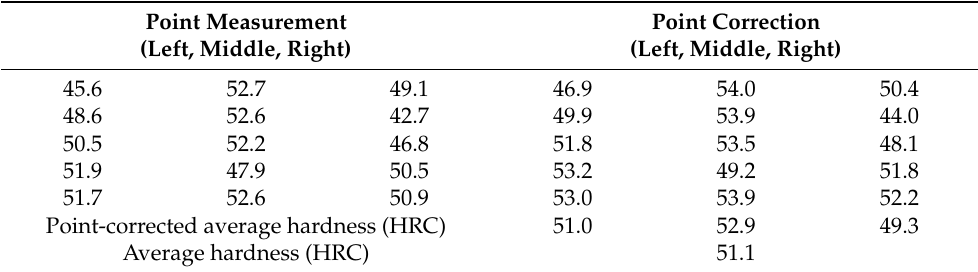
Table 3. Result table of surface hardness values.